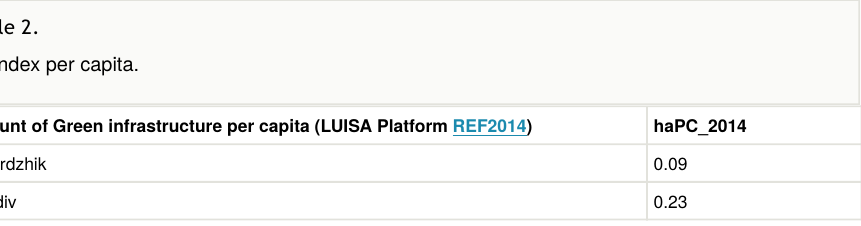
Figure 4. Distribution of the SOC values for 1992/93-2015. The decrease in the overall SOC concentration for the 2015 dataset indicates higher SOC accumulation over time, which equals the C sequestration rates. The climatic conditions (rainfall and temperature), soil characteristics (clay concentration), soil erosion and degradation and land use practices (arable land, grassland, agricultural farming) are some of the potential variables related to the analysis of the SOC stock. Interestingly, for observation year 2015, most of the values are clustered in the intervals 10-40 and 40-80 and, for observation year 1992/93, they vary between 6.08 and 38.42 t/ha. The SOM stock, in combination with the GI area, is also one of the representative indicators for the ES Global climate regulation by reduction of greenhouse gas concentrations. Globally, as containing over two-thirds of the soil carbon, forest ecosystems are considered as signi fi cant carbon sinks that play an important role in the carbon cycling and in climate regulation. The GI index is derived from calculations on the basis of amount of GI per capita. In the present research, for the Central Balkan region, the GI index is estimated on the average value of the available indices for the adjacent municipalities (Table 2). The index is calculated in hectares per capita (haPC) and can be successfully applied as it refers to the area of natural and semi-natural areas aggregated from the LUISA land use map.